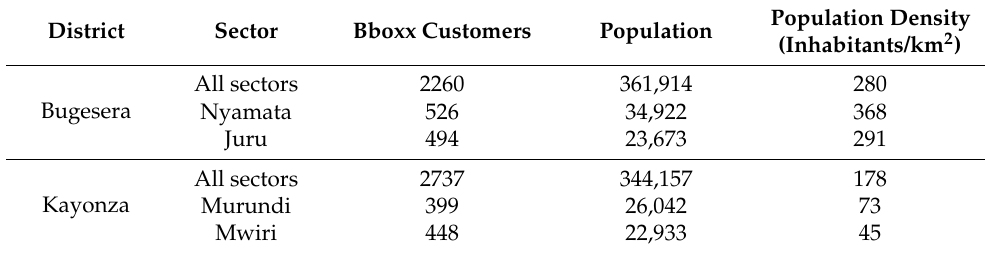
Table 1. Bboxx customers, population and population density by sector (adapted from [60]).